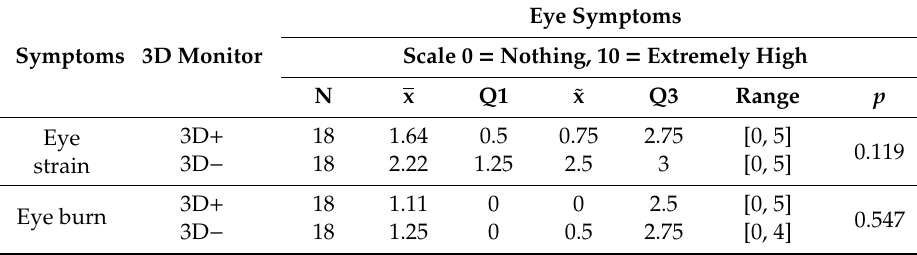
Table 4. Physical symptoms that participants experienced during the operation by using each system. Eye Symptoms Symptoms 3D Monitor Scale 1 = Nothing, 4 = Very High N x Q1 ˜ x Q3 Range p 3D + 18 1.17 1 1 1 [1, 2] Headache 0.219 3D − 18 1.39 1 1 2 [0, 3] 3D + 18 1.06 Nausea